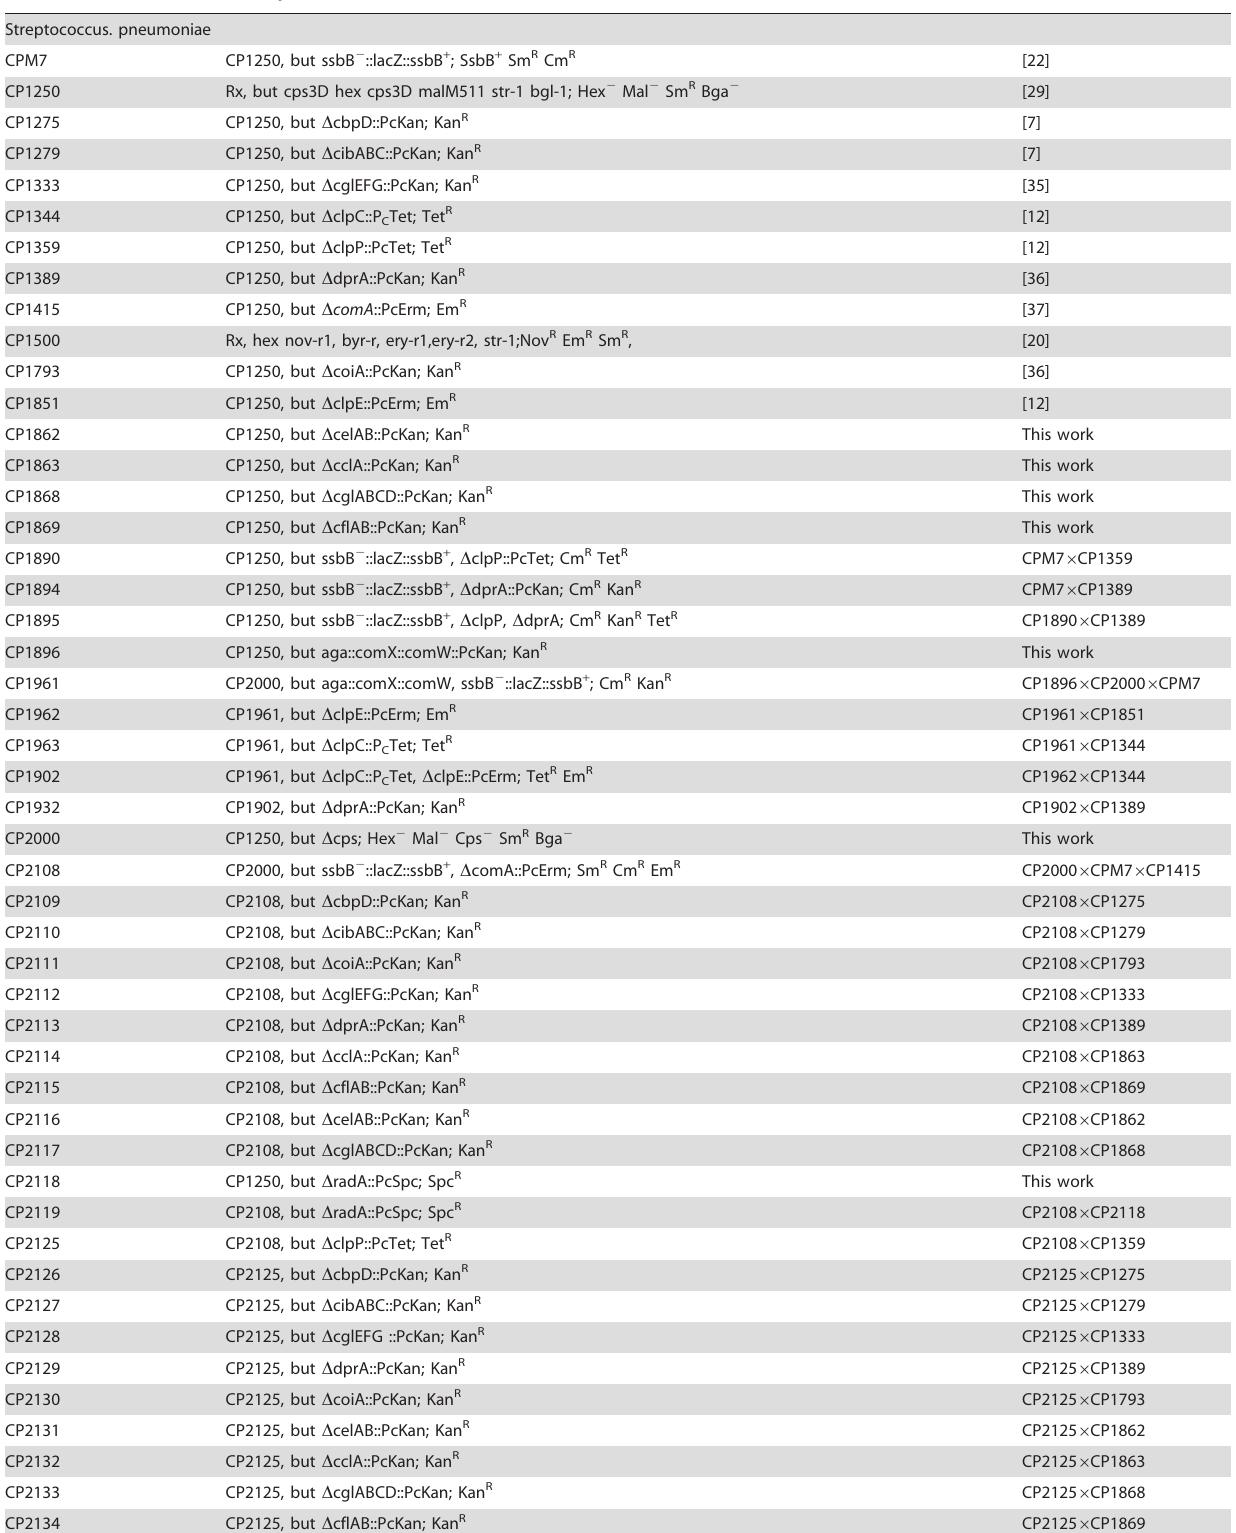
Strain Description Source (a) or reference Streptococcus.